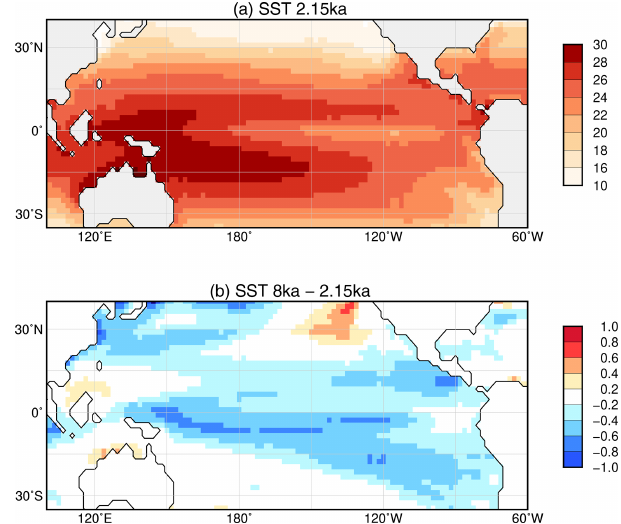
Figure B1. Simulated annual mean sea surface temperatures (SSTs) (K) for (a) the 2.15ka time slice and (b) the difference be- tween 8ka and